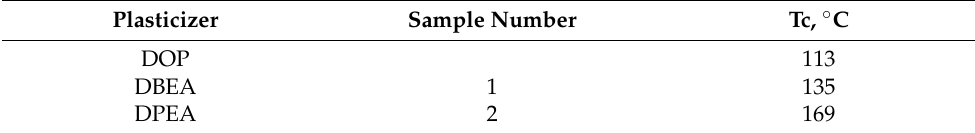
Table 4. The results of determining the critical temperature of the dissolution of the plasticizers.